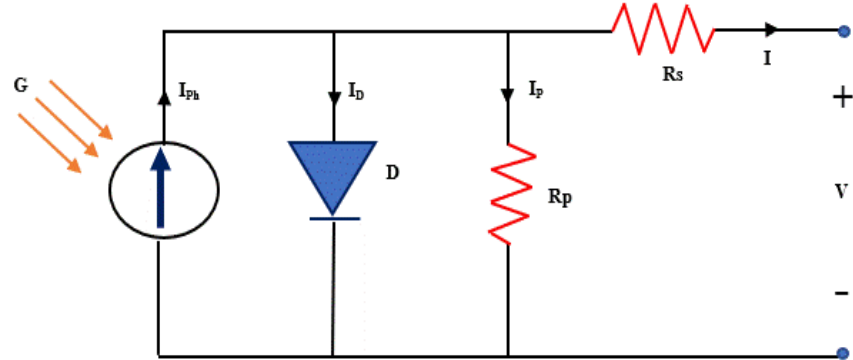
Figure 2. Electrical circuit of the single-diode solar cell.